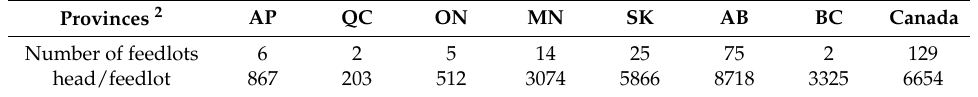
Table 2. Number of feedlot operations and feedlot cattle populations (based on capacity) for each province and for Canada reported by the Canadian Cattlemen Magazine 1 in 2013 and/or